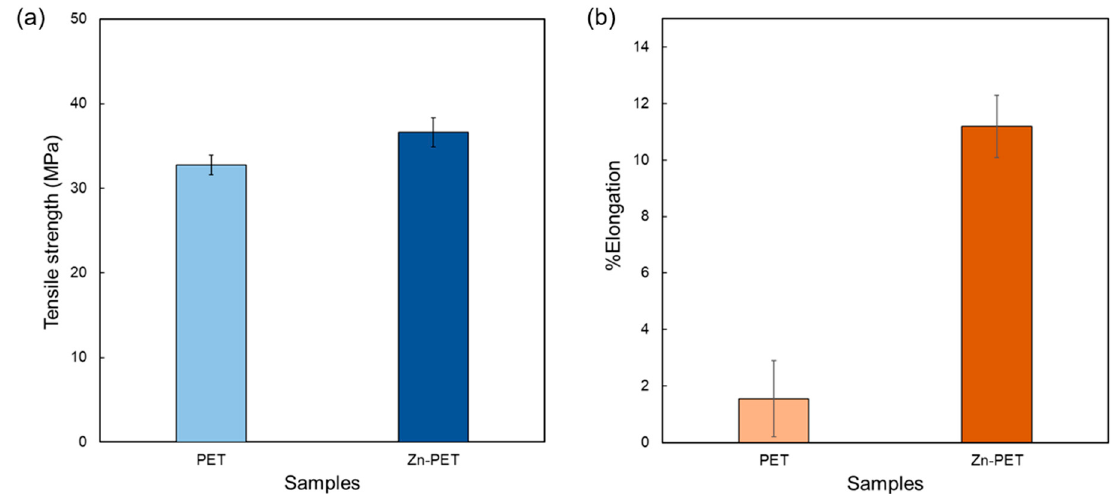
Figure 10. Tensile strength ( a ) and elongation at break ( b ) of the PET and Zn-PET (30 repeats) films. Means with different lowercase superscript letters are significantly different ( p < 0.05).